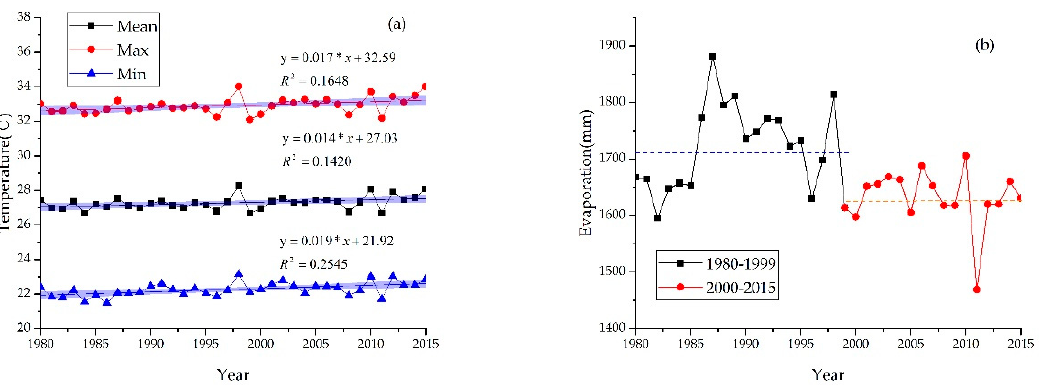
Figure 9. Variations of annual air temperatures (min, mean and max) ( a ) and evapotranspiration ( b ) in the Mun River basin during 1980–2015.